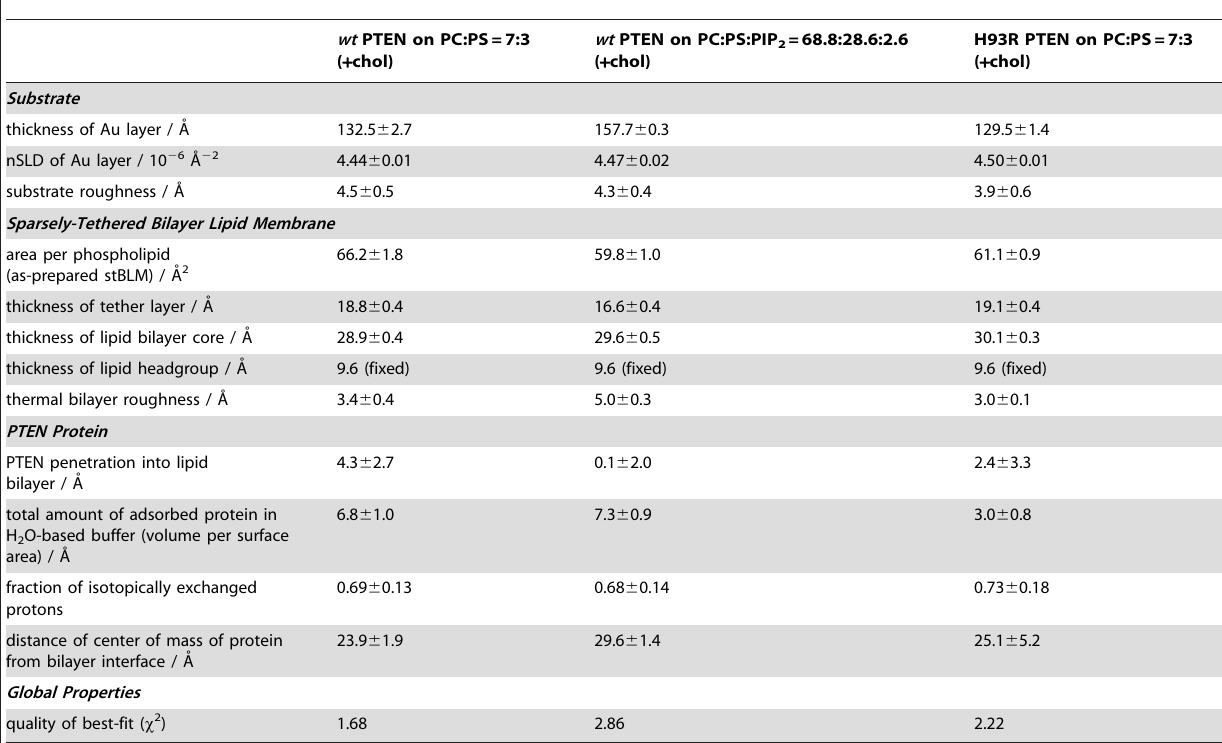
Table 3. Parameters of the best-fit model for the neutron reflection from stBLMs with associated PTEN proteins.